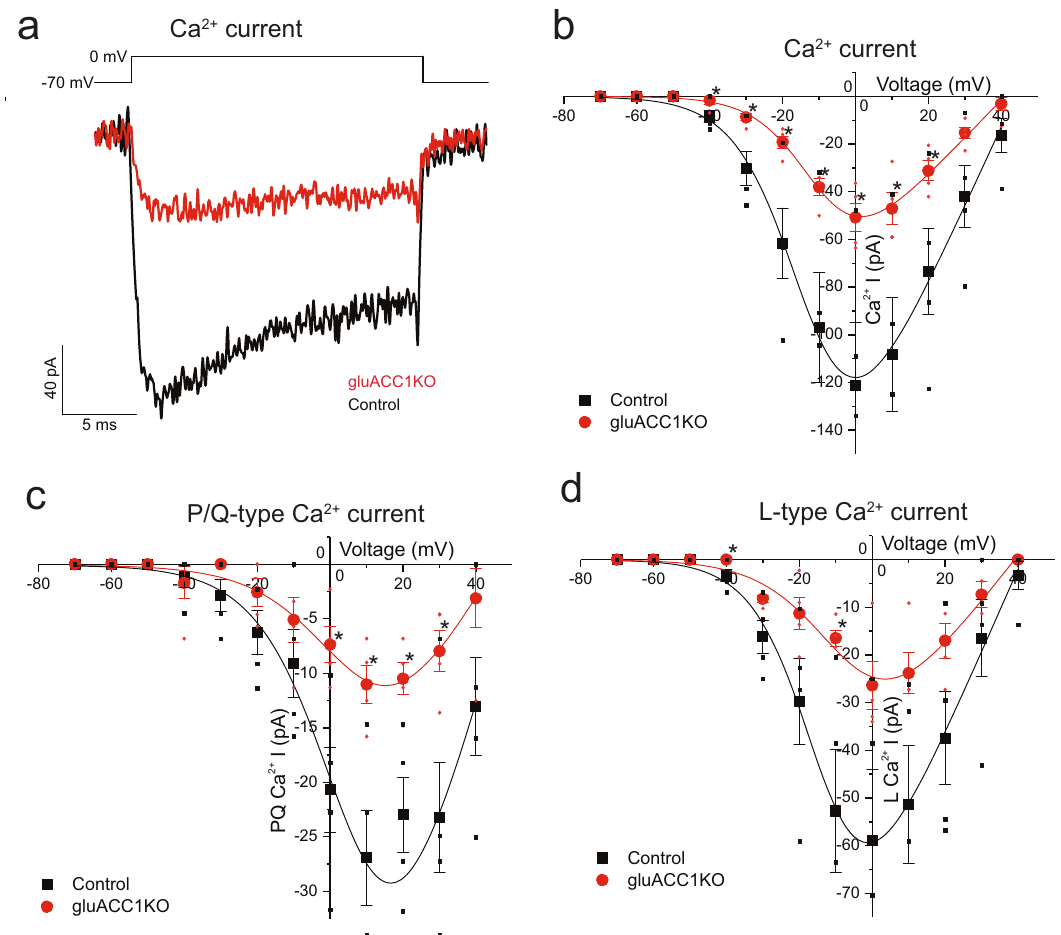
Fig. 5 ACC1 is necessary for the maintenance of voltage-gated calcium currents in alpha cells. Electrophysiological recordings of Ca 2 + currents triggered by a series of 20 ms depolarising pulses (from − 70 to + 40 mV with a 10 mV step increment) from a holding potential of − 70 mV in control (black trace/ squares) and gluACC1KO (red trace/circles) alpha cells within intact islets. Current – voltage relationships were fi tted with a Boltzmann function. a , b Representative Ca 2 + current trace ( a ) and summary of the amplitude of Ca 2 + currents ( b ) in the presence of 0.1 µ g/ml tetrodotoxin to block Na + channels. c Summary of the amplitude of P/Q-type Ca 2 + currents ( ω -agatoxin VIA-sensitive component). d Summary of the amplitude of L-type Ca 2 + currents (isradipine-sensitive component). Data from n = 4 independent islet preparations analysed by t -test. All data presented as mean ± SEM. Signi fi cance threshold: * P <